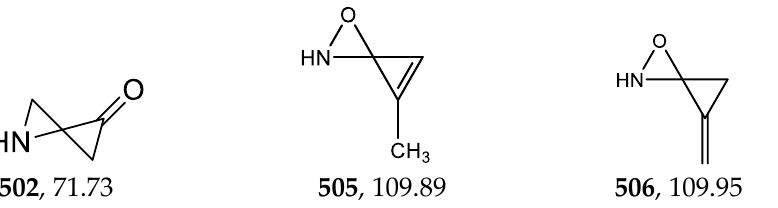
Figure 4. The least stable compounds found in the whole study and their relative Gibbs free energies (kcal/mol). Hydrogen: light grey, Carbon: black, Nitrogen: blue, Oxygen: red.